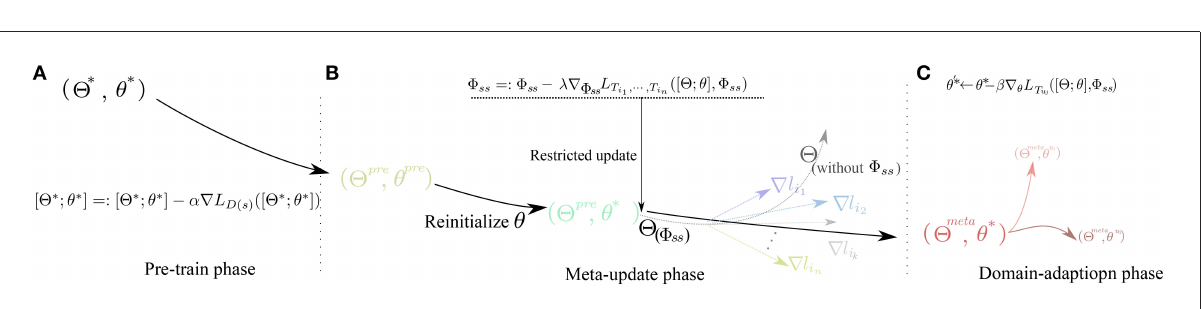
FIGURE3 Diagram of parameters variation through the learning process in different phases. (A) Pre-train phase, (B) Meta-update phase, and (C) Domain-adaption